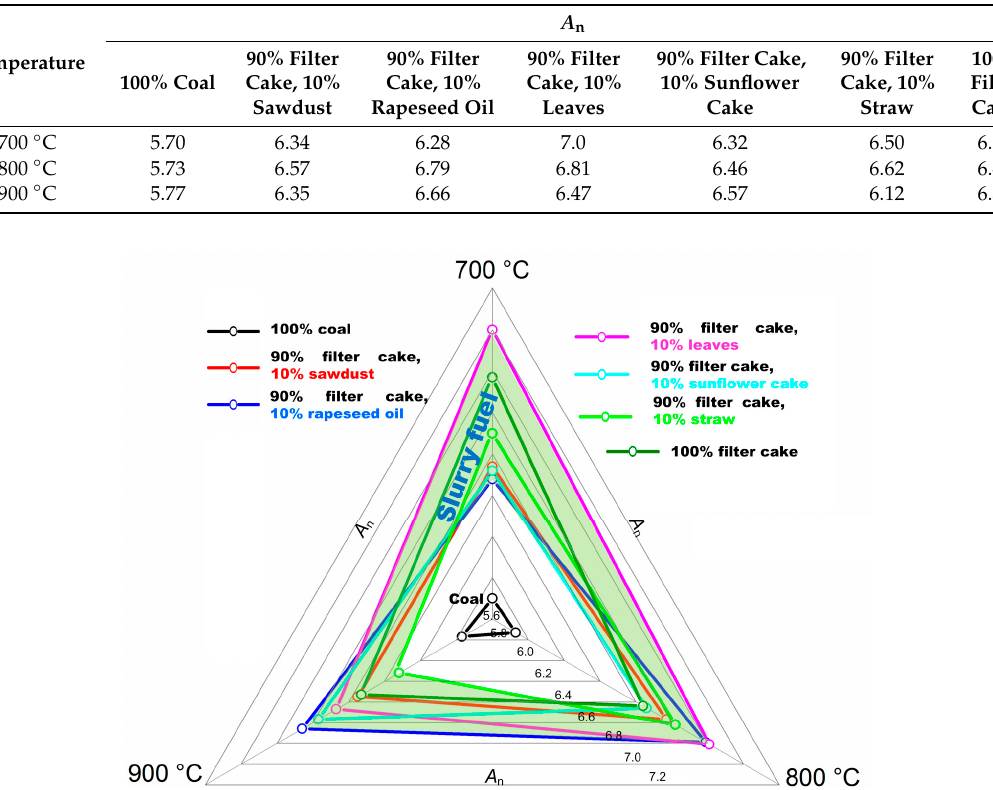
Figure 5. Comparison of integral efficiency indicator for all the fuels under study.